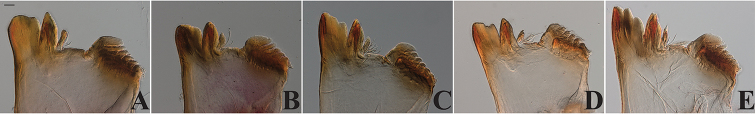
Outer incisor variability across conspecific samples. Dudgeodes
pangantihoni sp. nov. A EPH163 B EPH165 C EPH168 D EPH207 E EPH212. Scale bar: 20 μm.